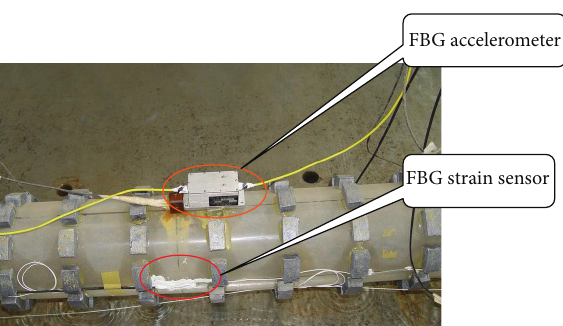
Figure 6: Photo of accelerometer on submarine pipeline model.